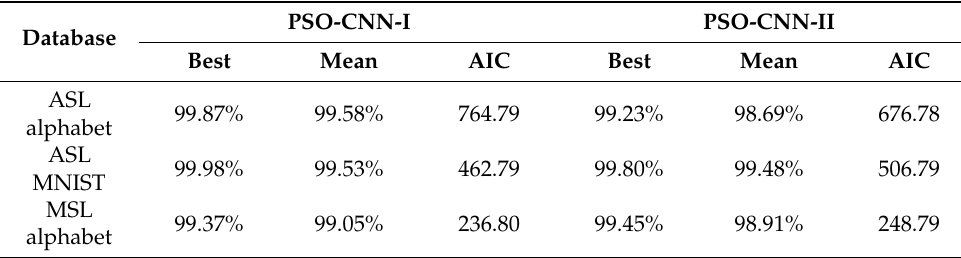
Table 15. Summary of the results obtained in the PSO-CNN-I and PSO-CNN-II